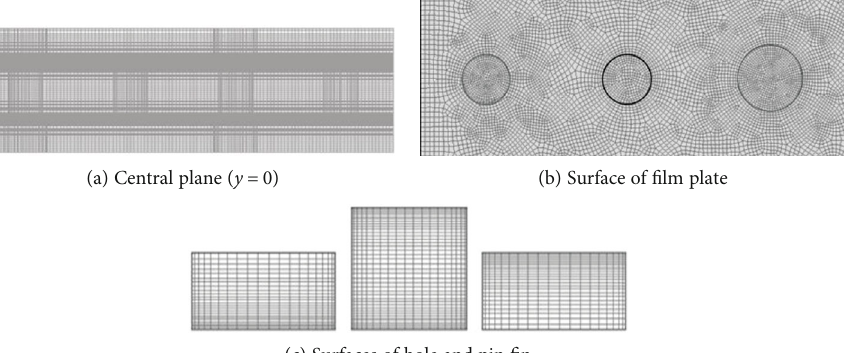
Figure 3: Grids used in the present study.